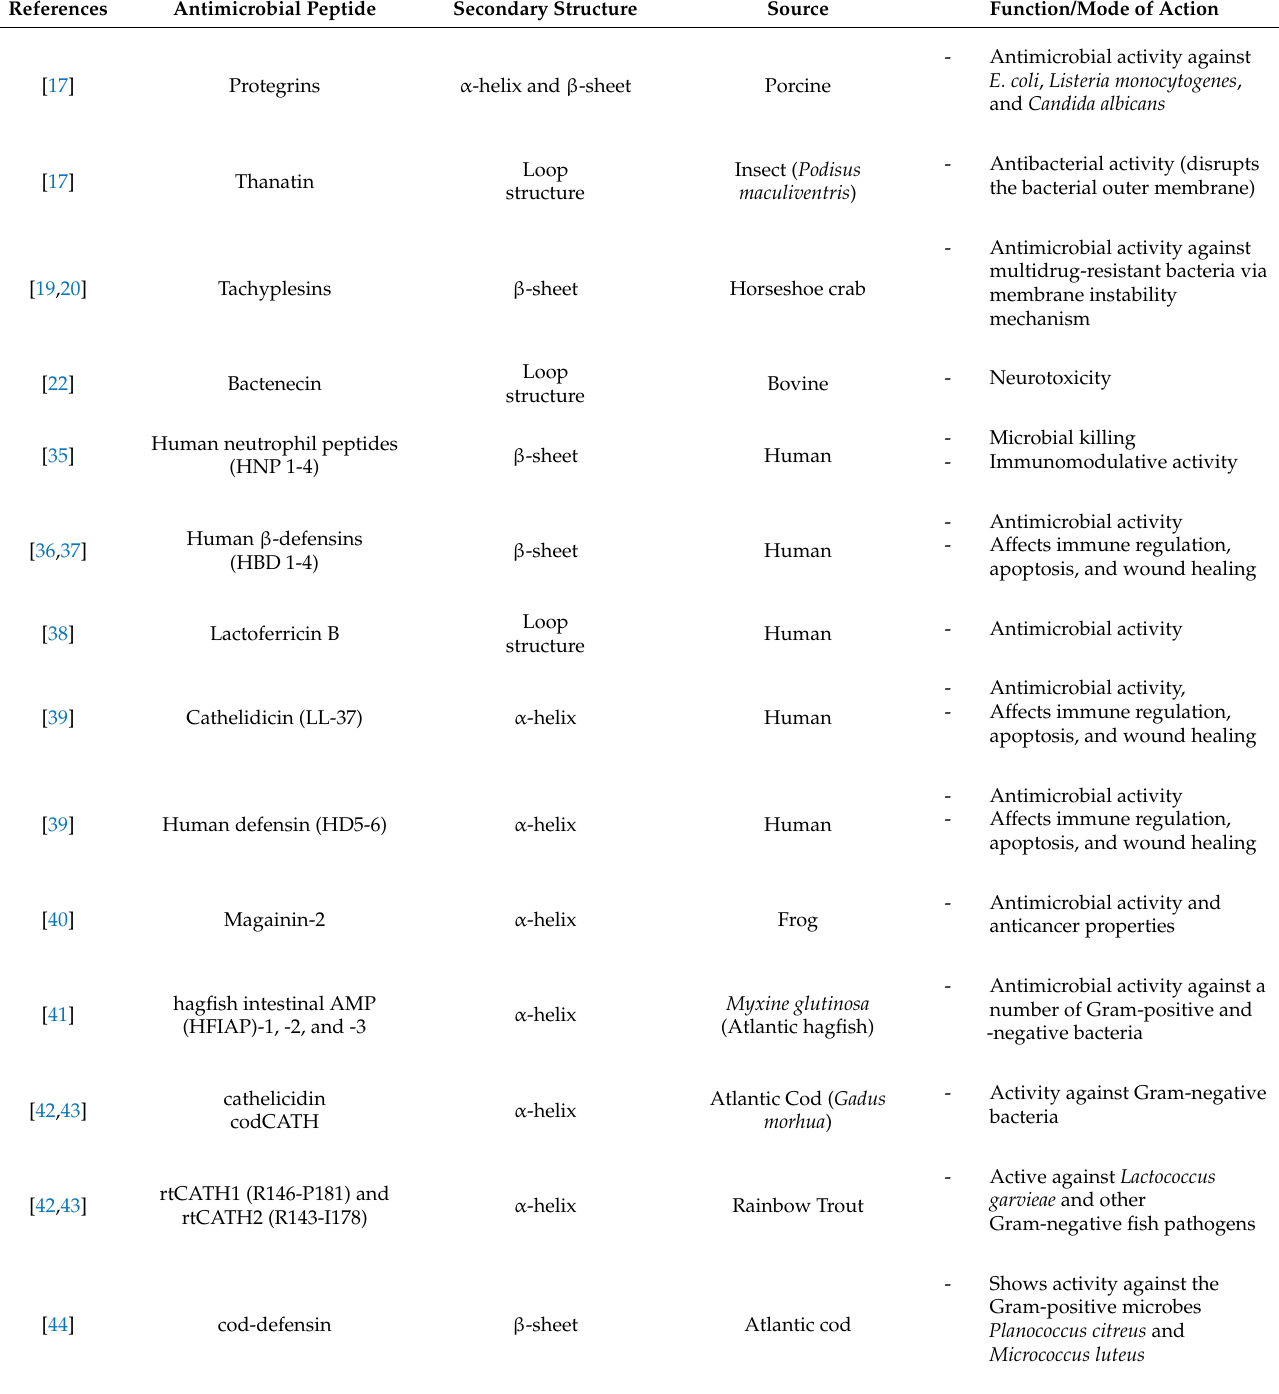
Table 1. Examples of antimicrobial peptides and their secondary structures, sources, and